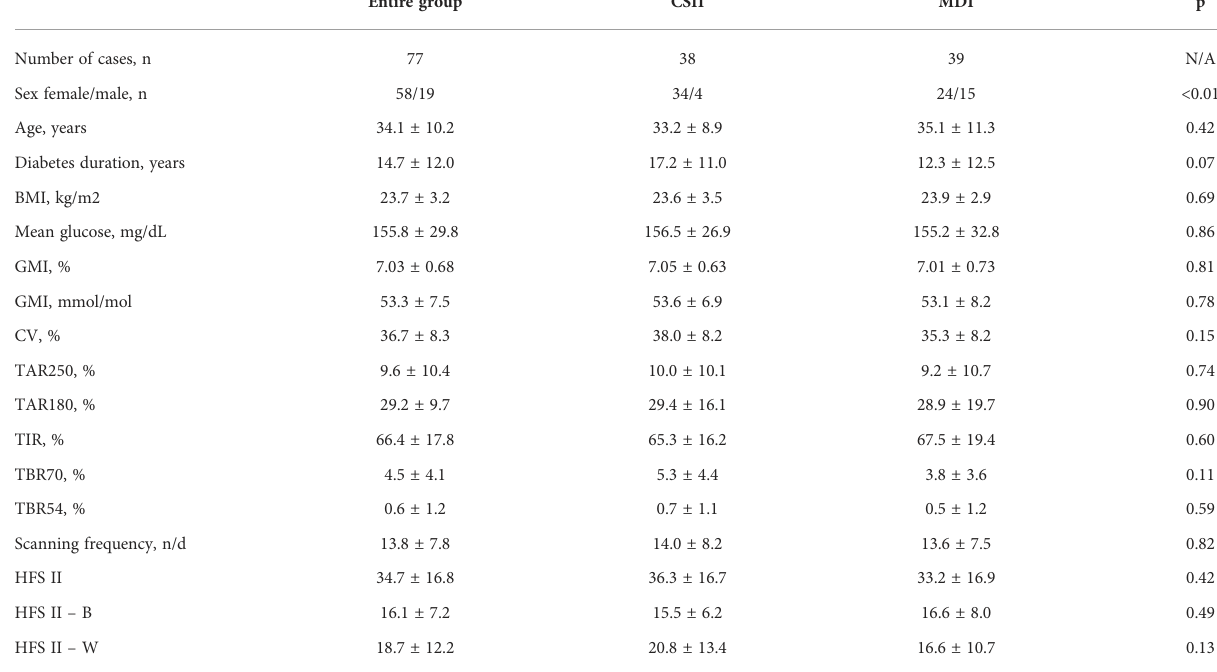
TABLE 1 Clinical characteristics of the study